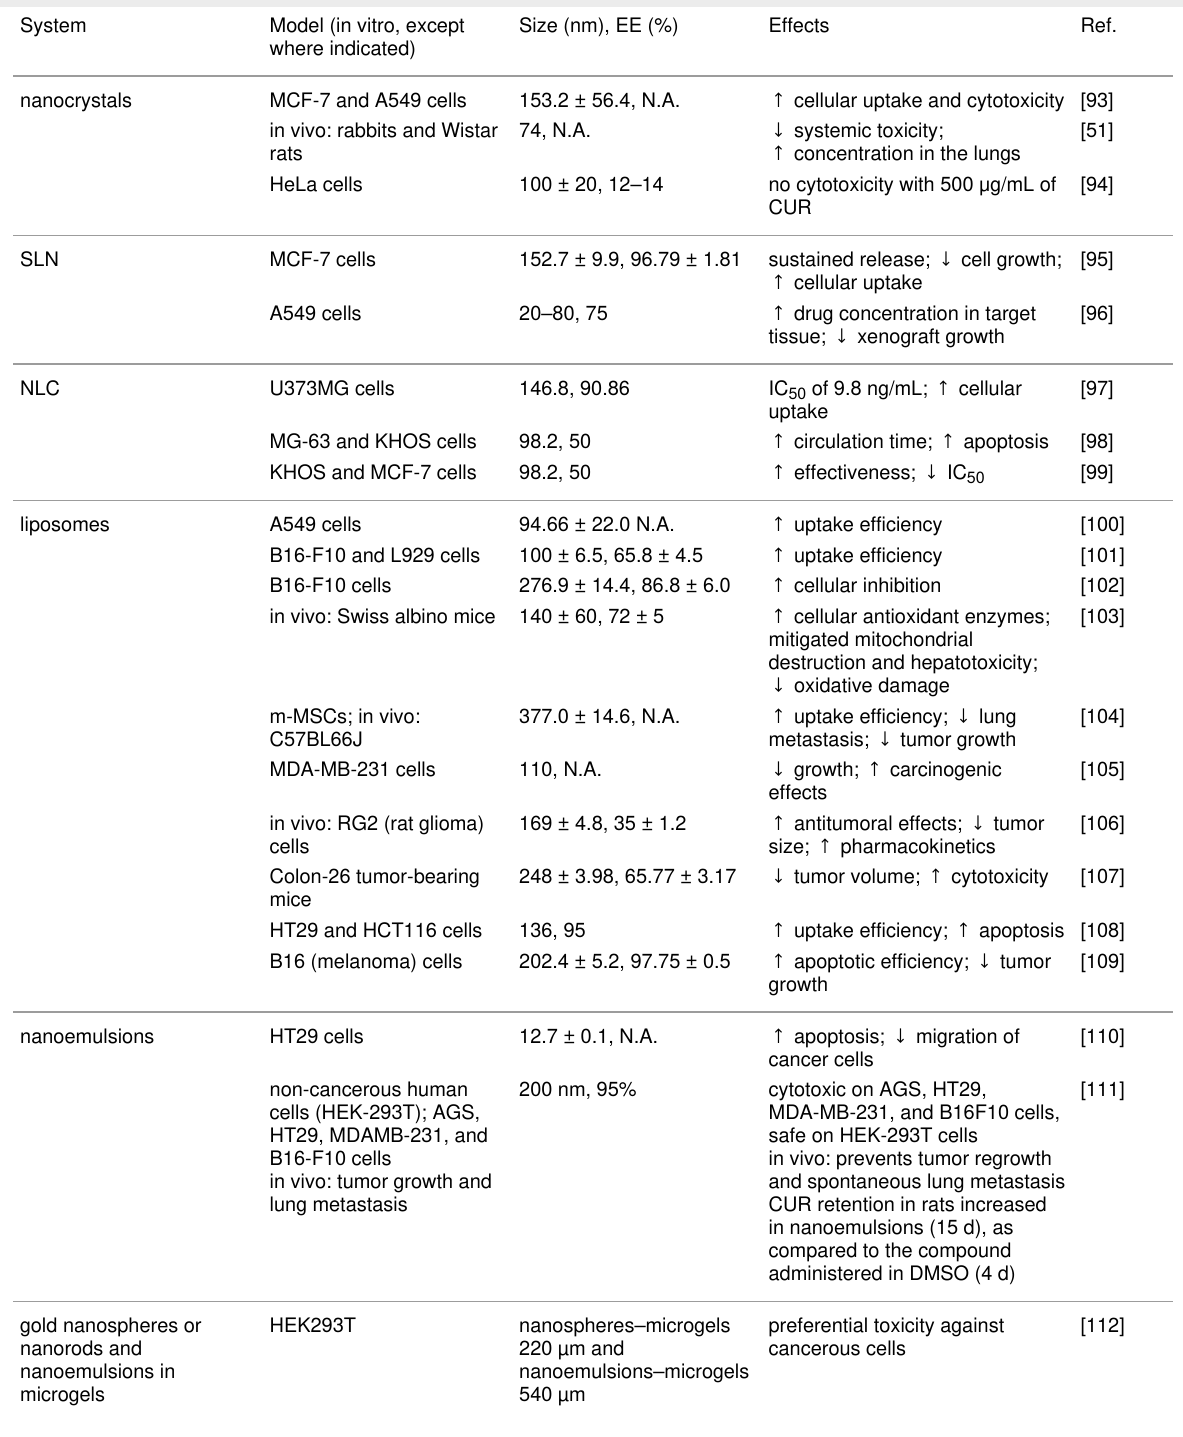
Table 1: CUR-loaded nanosystems in which significant anticancer effects have been reported.